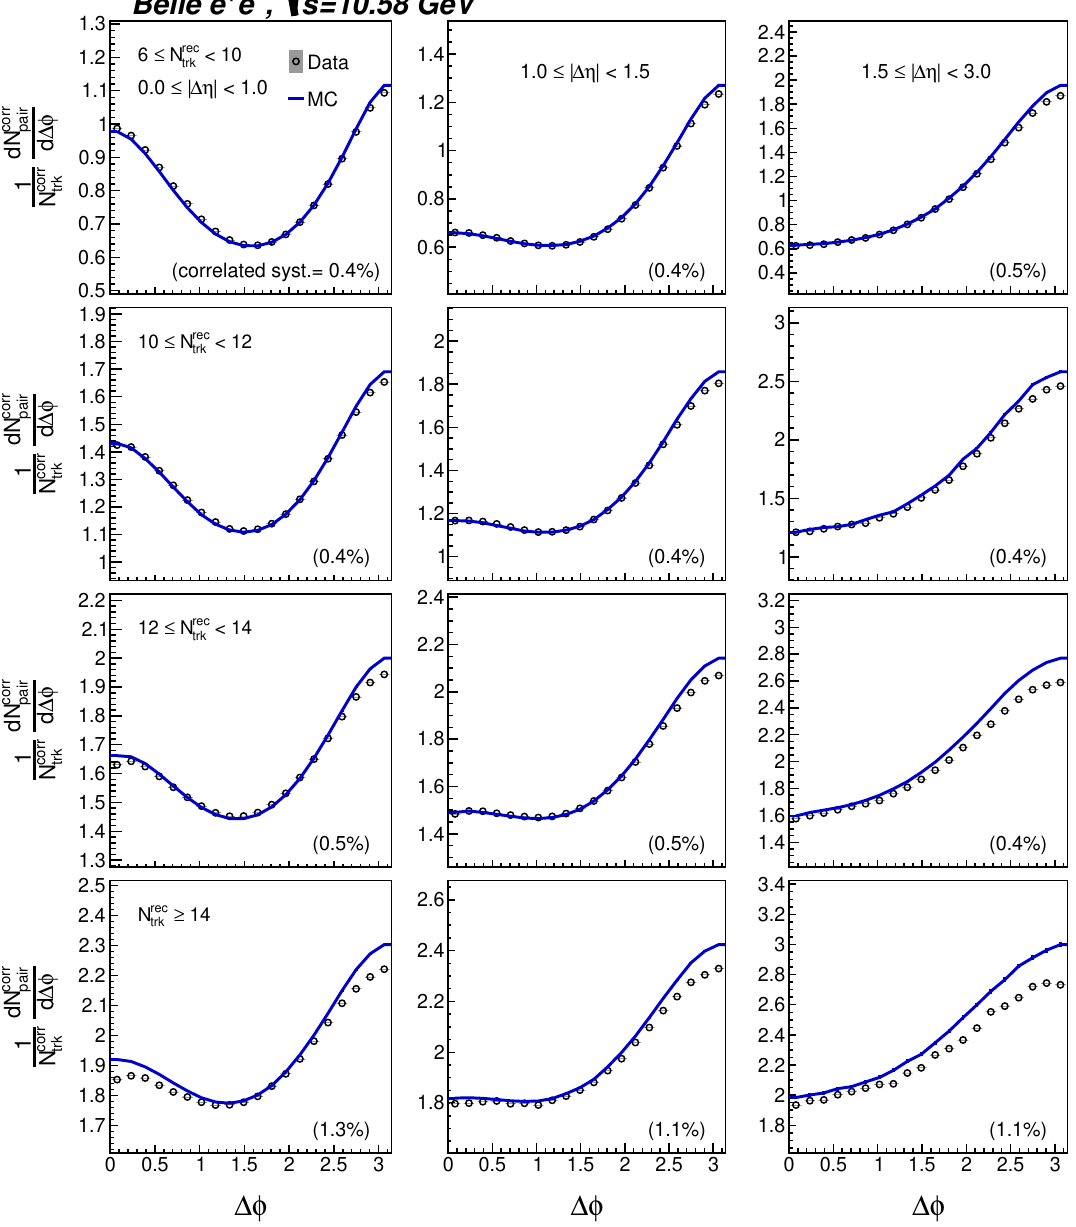
Figure 5. Beam-axis azimuthal differential associated yields as a function of the reconstructed- track multiplicity N rec for the on-resonance sample in the short-range ( 0 ≤ | ∆ η | < 1 ), middle-range trk ( 1 ≤ | ∆ η | < 1 . 5 ) and long-range ( 1 . 5 ≤ | ∆ η | < 3 . 0 ) regions in columns from left to right,